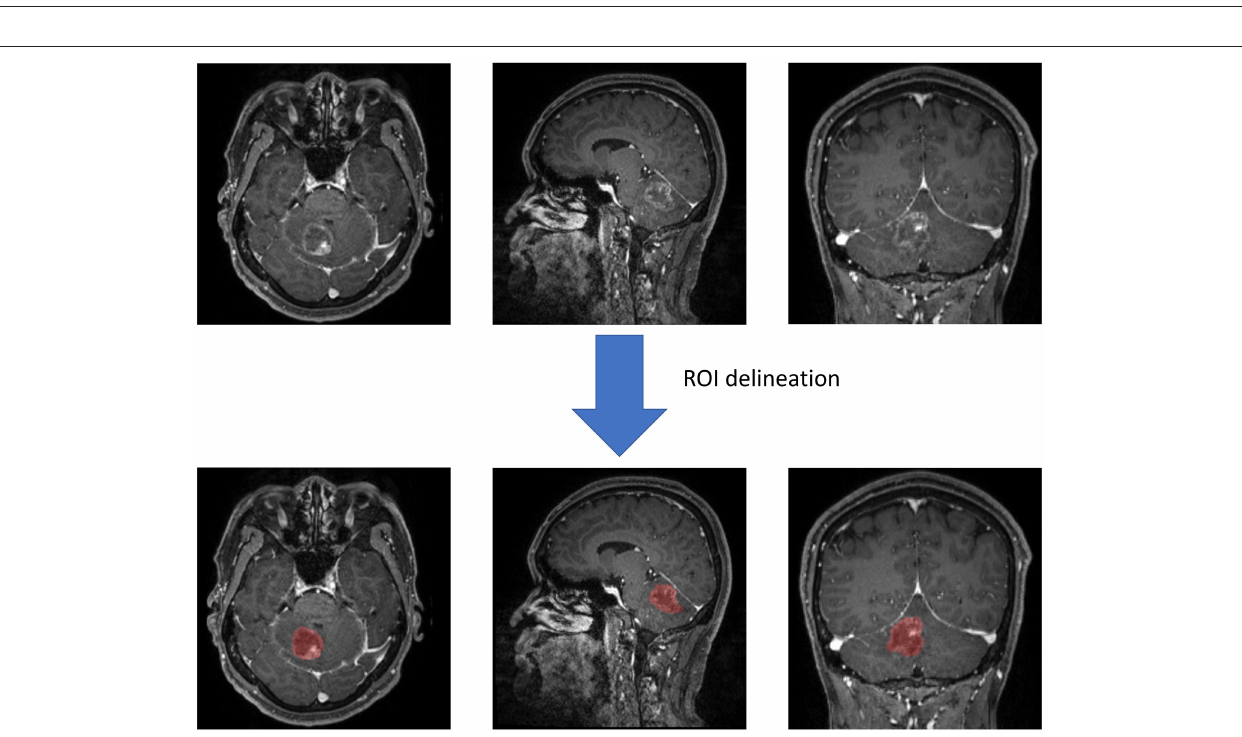
FIGURE 2 | Screen capture of regions of interest (ROI)